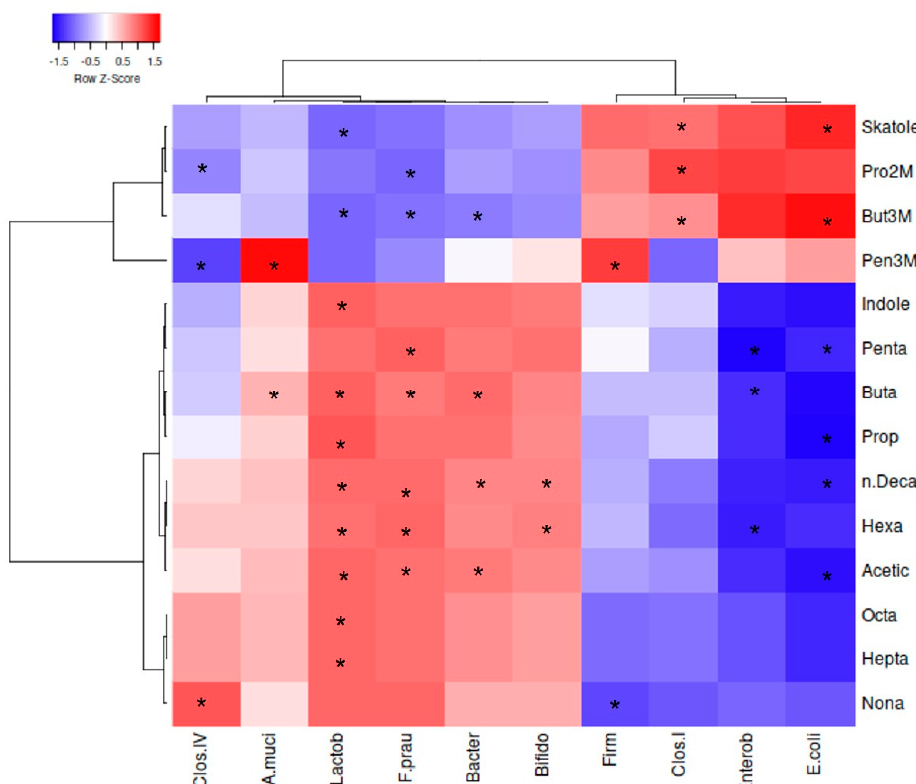
Figure 7. Spearman Rank Correlations among VOCs and microbial groups. Clos.IV = Clostridium group IV; A.muci = Akkermansia muciniphila ; Lactob = Lactobacillales ; F.prau = Faecalibacterium prausnitzii ; Bacter = Bacteroidetes ; Bifido = Bifidobacteriaceae ; Firm = Firmicutes ; Clos.I = Clostridium group I; Enterob = Enterobacteriaceae ; E. coli = Escherichia coli ; Pro2M = Propanoic acid, 2-methyl; But3M = Butanoic acid, 3-methyl; Pen3M = Pentanoic acid, 3-methyl; Penta = Pentanoic acid; Buta = Butanoic acid; Prop = Propanoic acid; Acetic = Acetic acid; n.Deca = n-Decanoic acid; Hexa = Hexanoic acid; Octa = Octanoic acid; Hepta = Heptanoic acid; Nona = Nonanoic acid. Dendrograms are made by Pearson analysis with complete linkage. * Significance of correlations by Spearman Rank analysis ( p < 0.05) ( p values are reported in Figure S2).